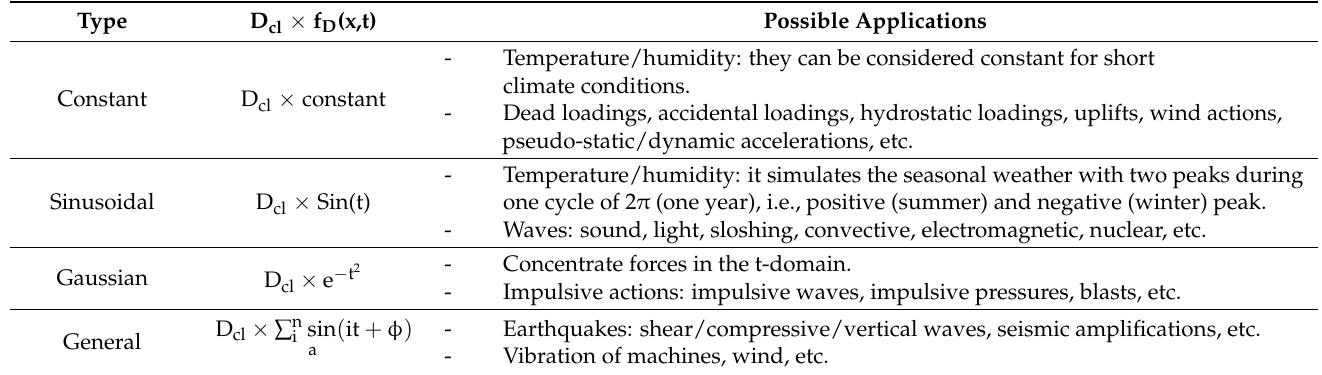
Table 4. Four generic functions f D (x,t) and their applications (proposed